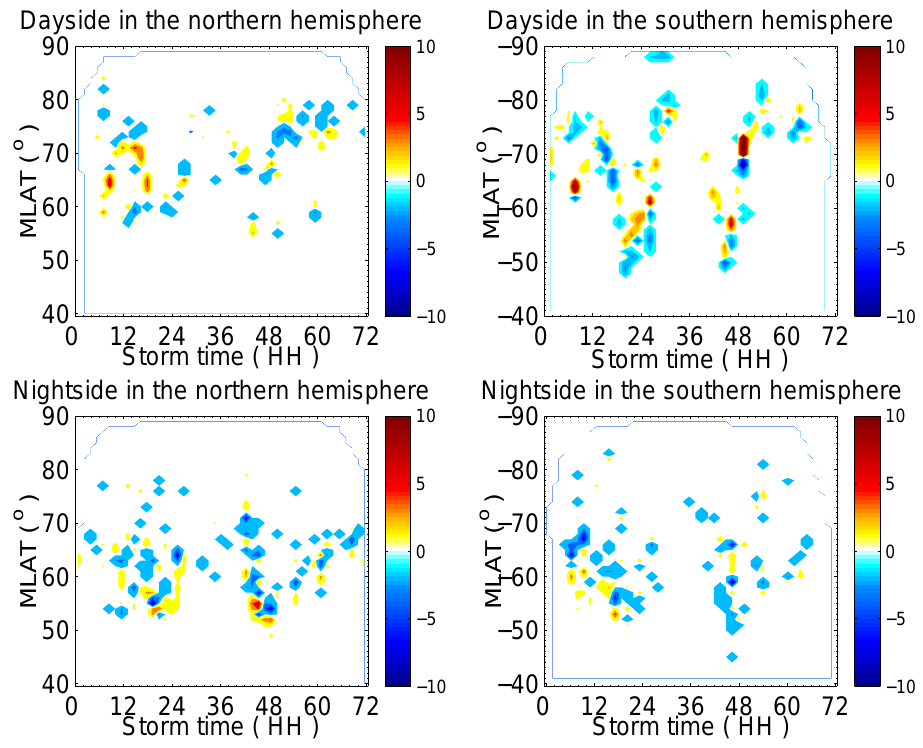
Fig. 3. Storm-time FACs observed by CHAMP in the daytime (top) and nighttime (bottom) sectors on 29–31 October 2003 in the Northern (left) and Southern(right) Hemispheres. Current densities are given in µ A/m 2 .